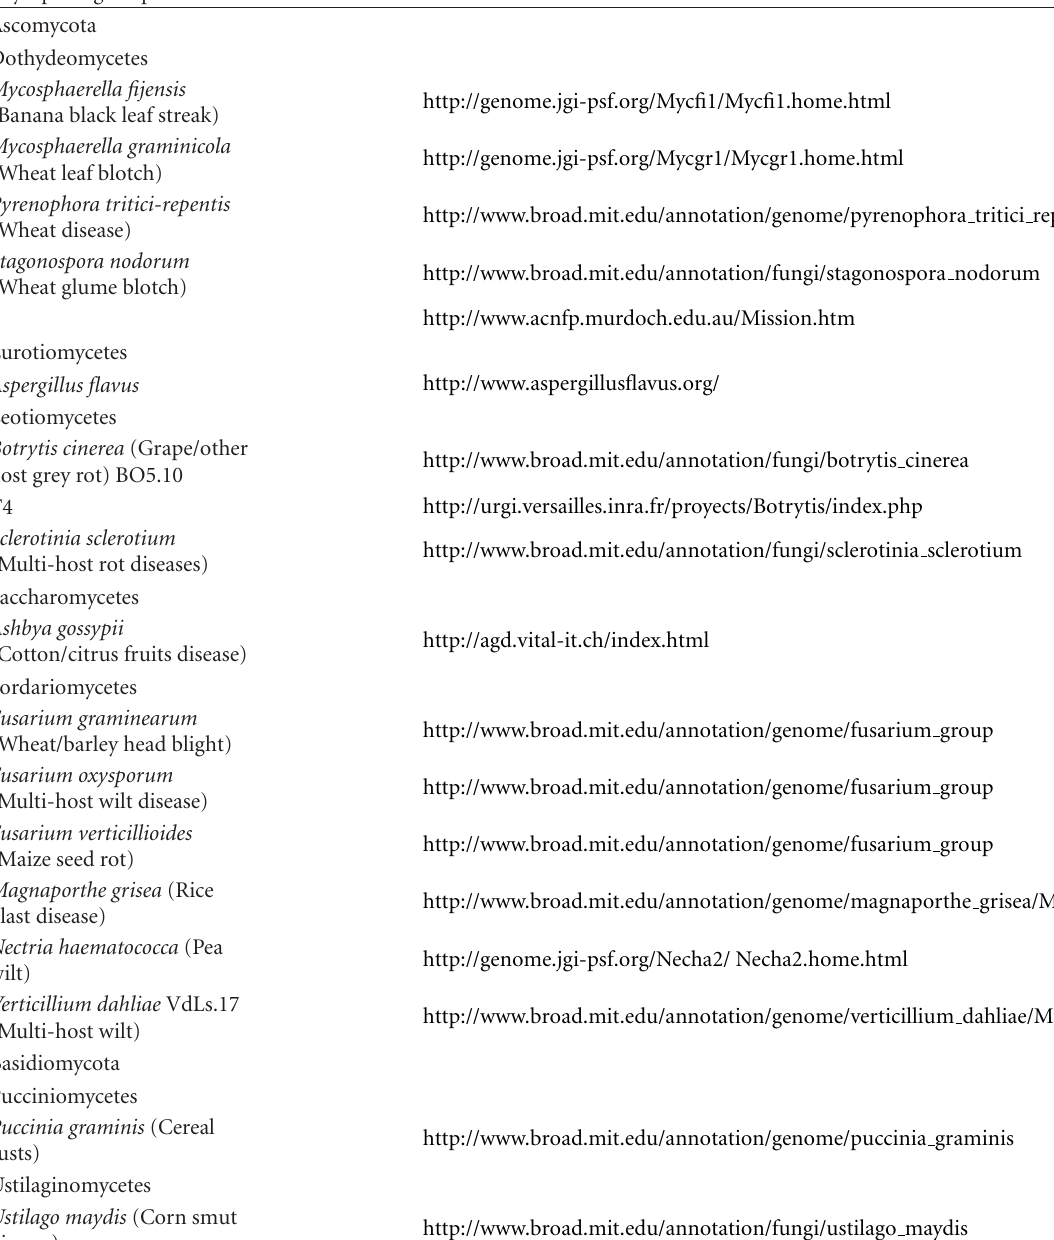
Table 2: Publicly available plant pathogenic fungal Genome